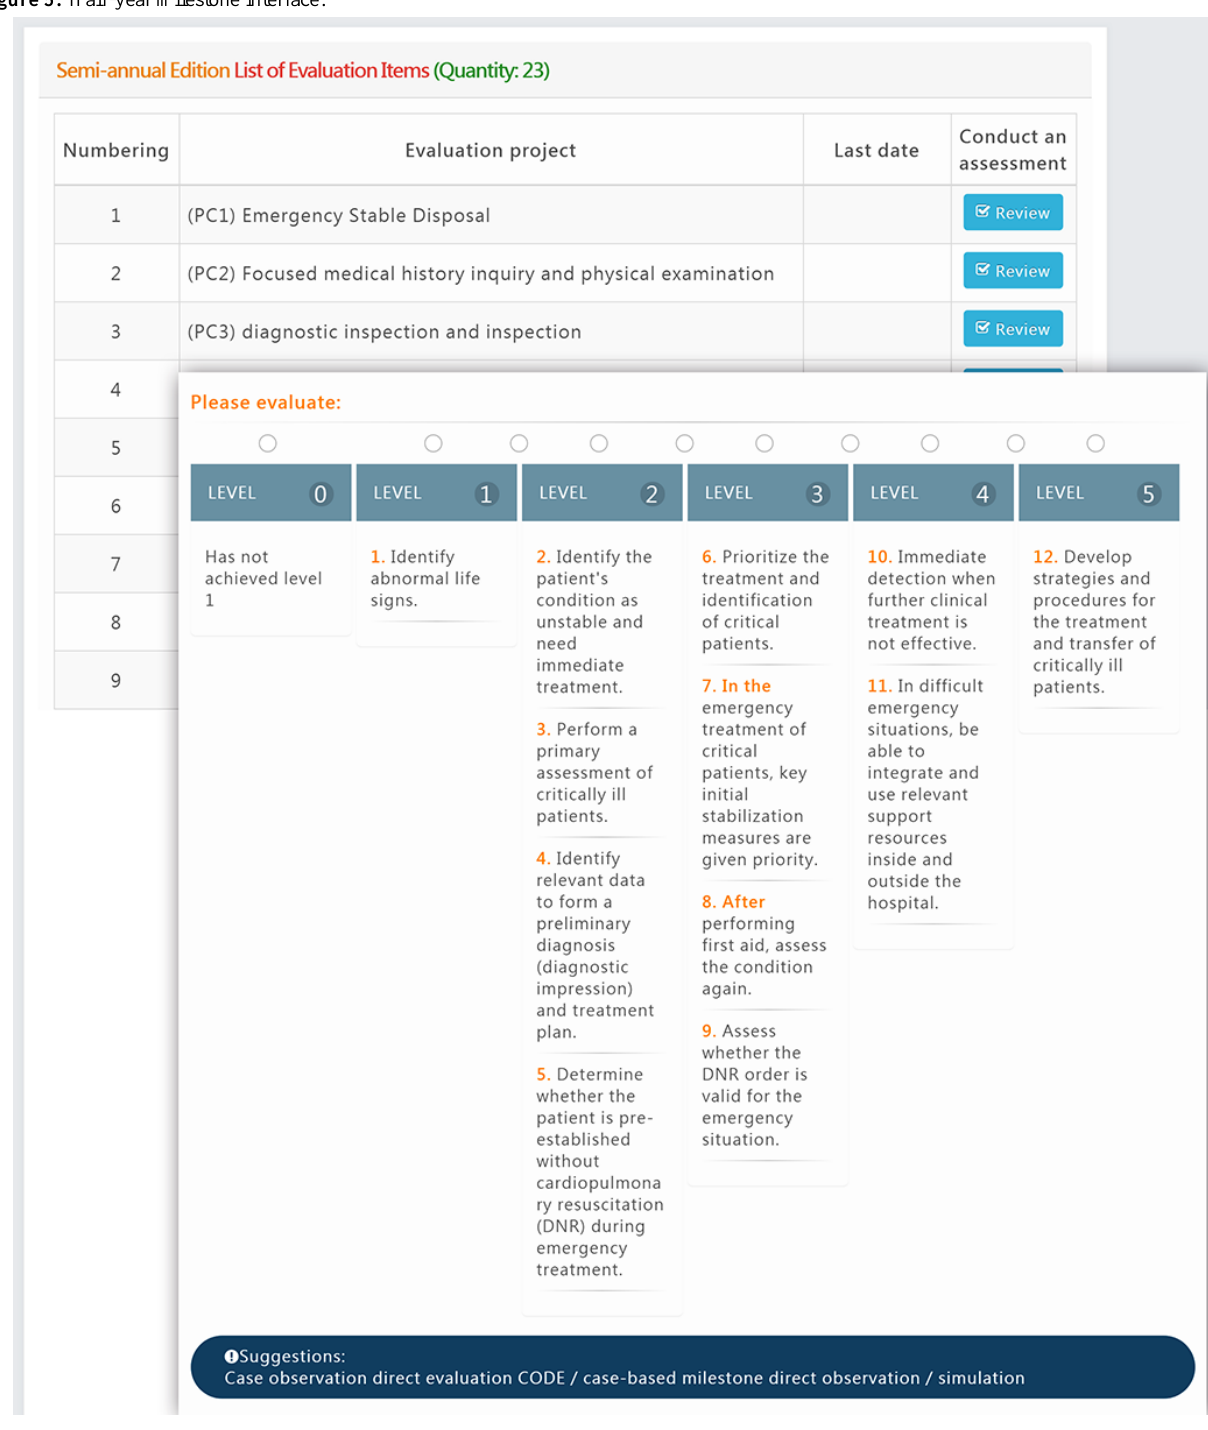
Figure 5. Half-year milestone